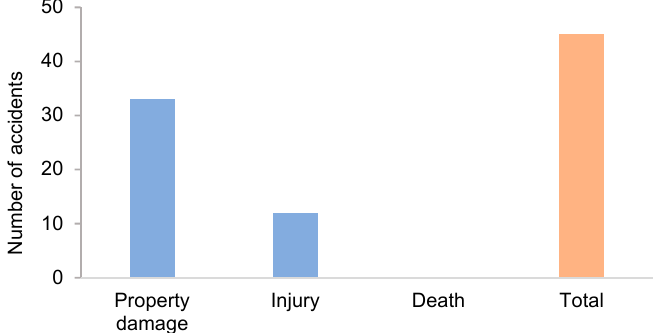
Figure 5. Numbers and types of accidents on Buraydah Ring Road in year 2018–2019.